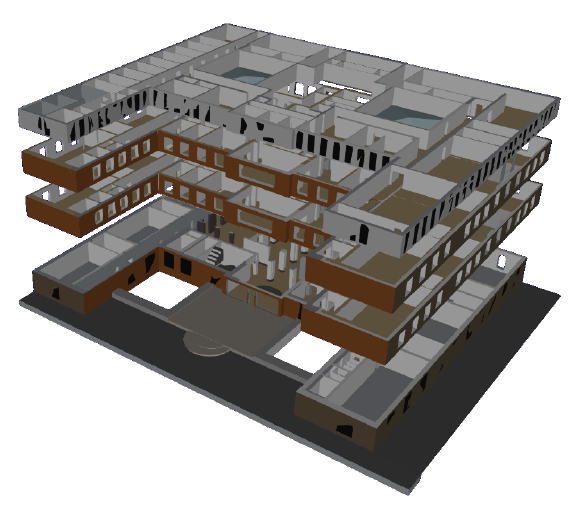
Figure 4. Overview of the 4-storey test building. Each floor is a single 3D model which can be managed separately. (Bottom-Top) Test building ground floor; first floor, second floor; third